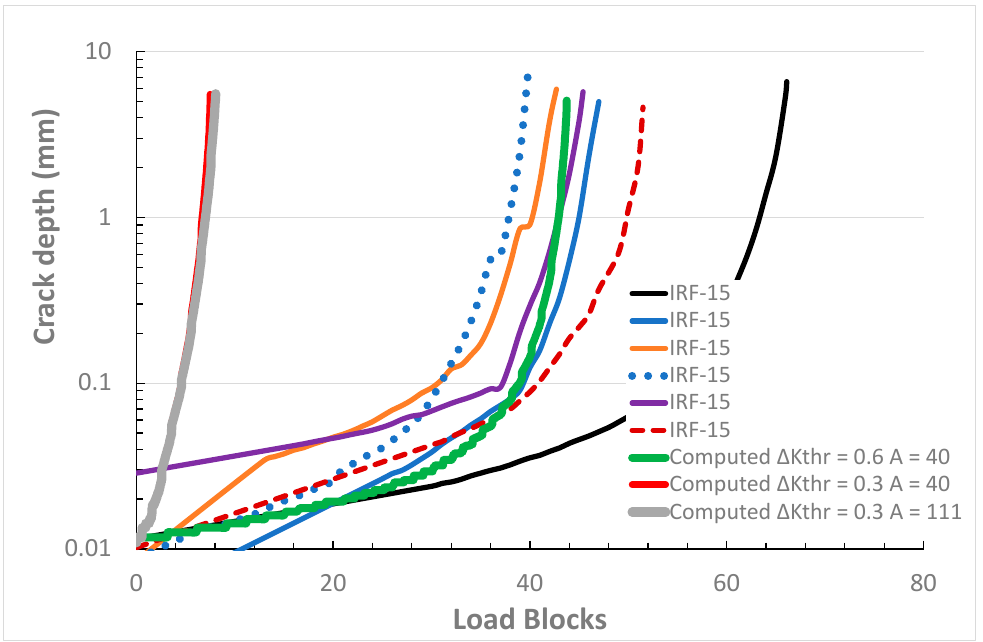
Figure 14. The effect of different toughness on the measured and computed curves for the helicopter flight load spectra IRF-E15.